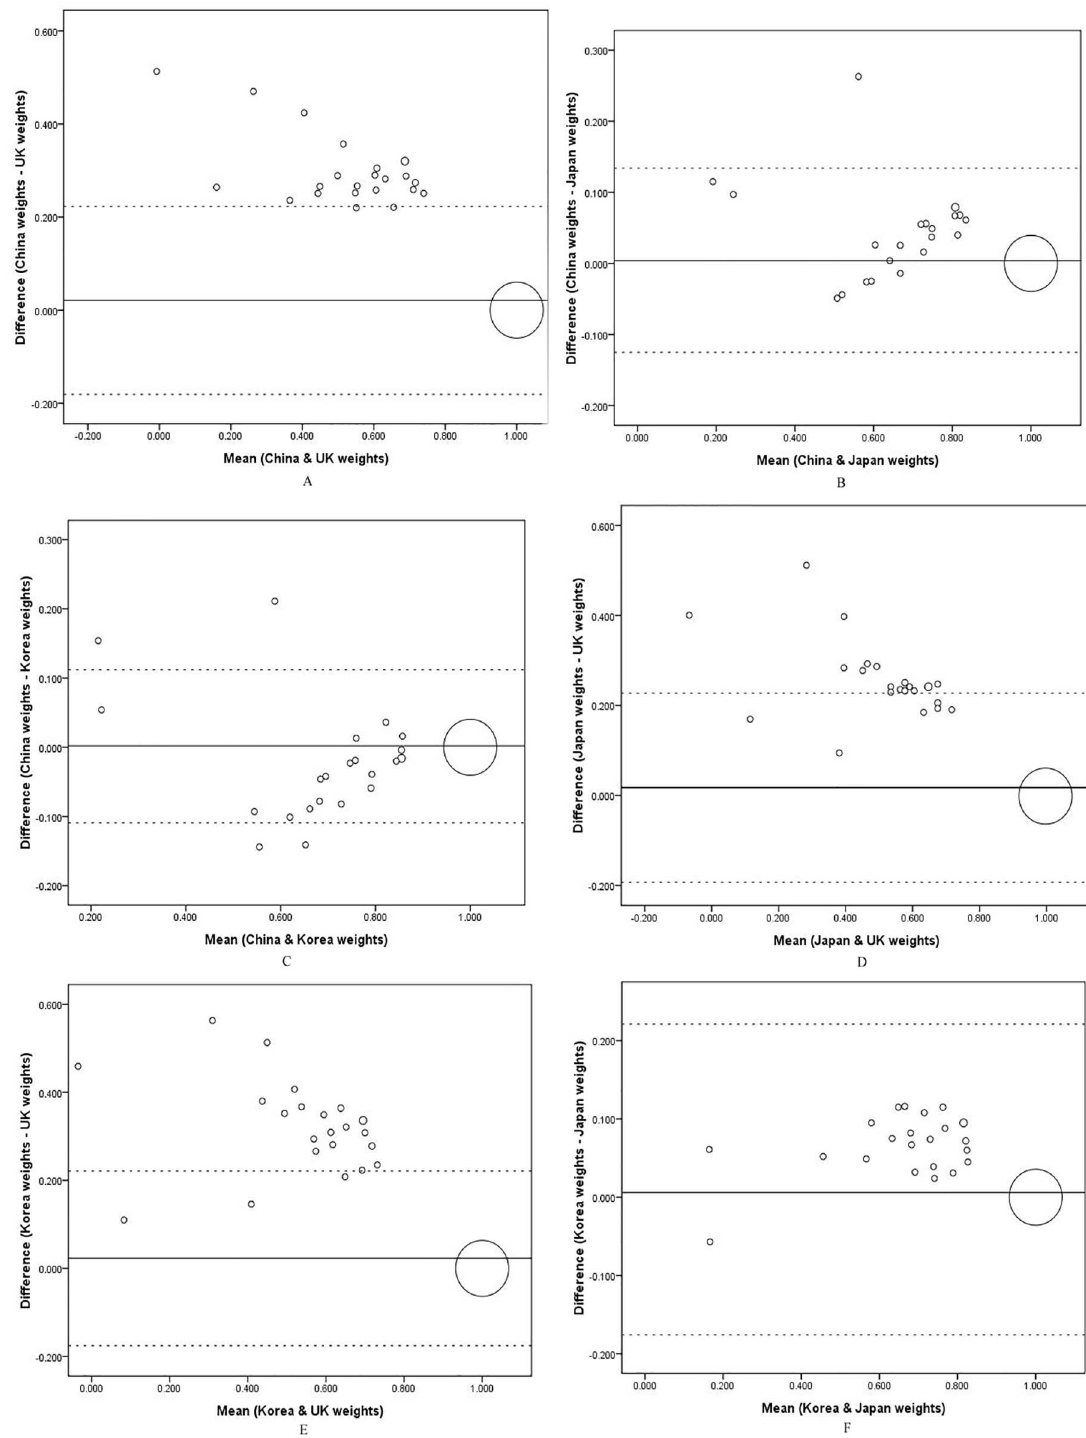
Fig 1. a-f. The Bland-Altman plots of EQ-5D scores derived from the China, UK, Japan, and Korea preference weights.